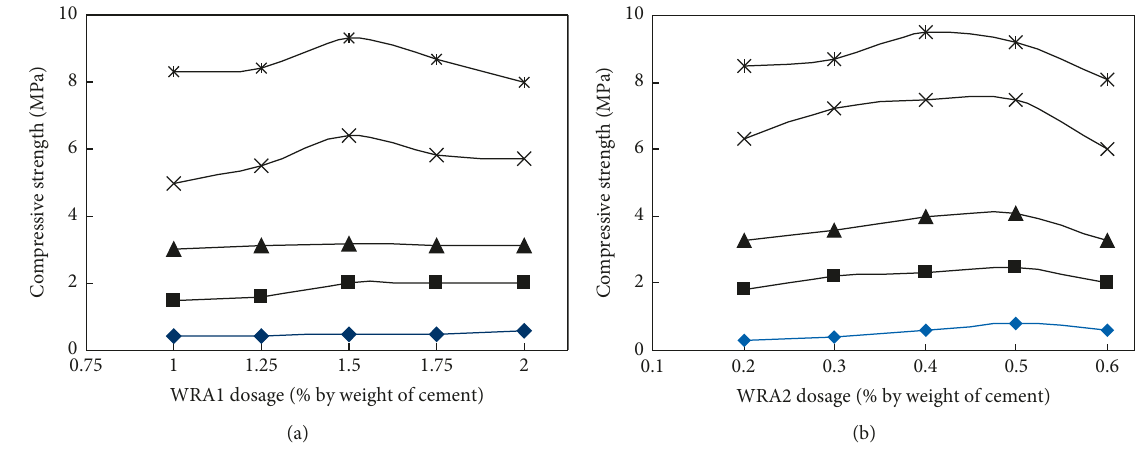
Figure 6: Cube compressive strength of CGCBM mixed with different dosages of WRA.